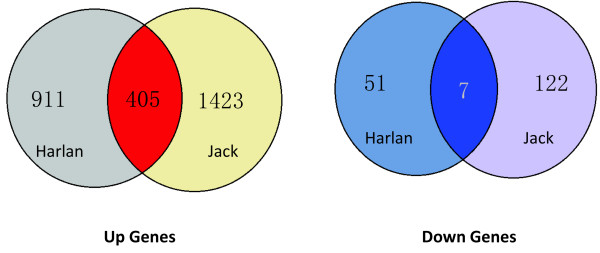
Common differentially expressed genes of the two mouse breeds studied. The red and blue parts represent, respectively, the upregulated common differentially expressed genes (DEGs) and downregulated common DEGs.